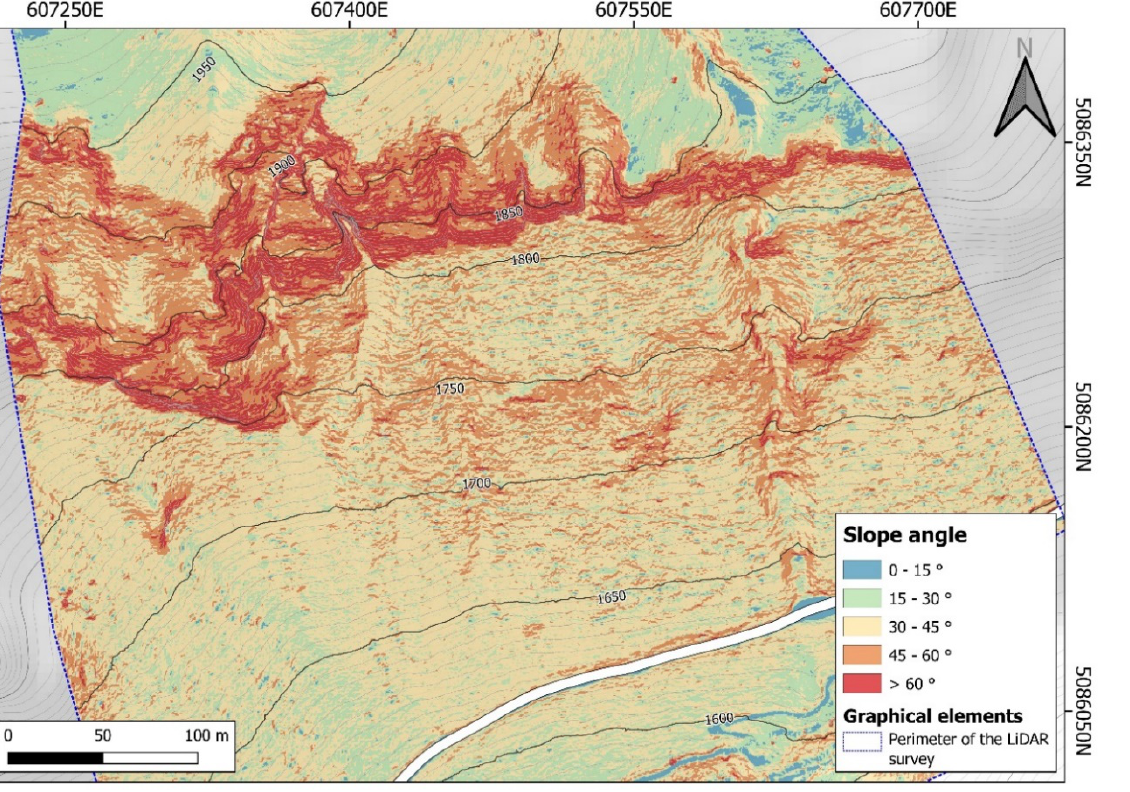
Figure 6. Exposition (aspect) of the entire study area; the average value is SSE. For the rock faces in the upper portion of the slope, the variation is much more significant, with sectors facing ENE to NNE.